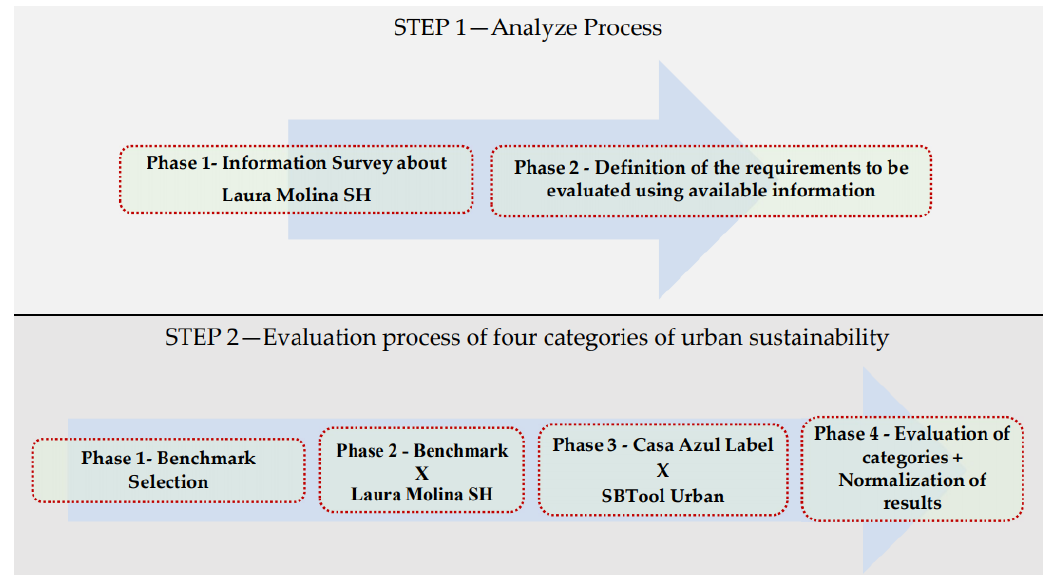
Figure 3. Flowchart of the study .